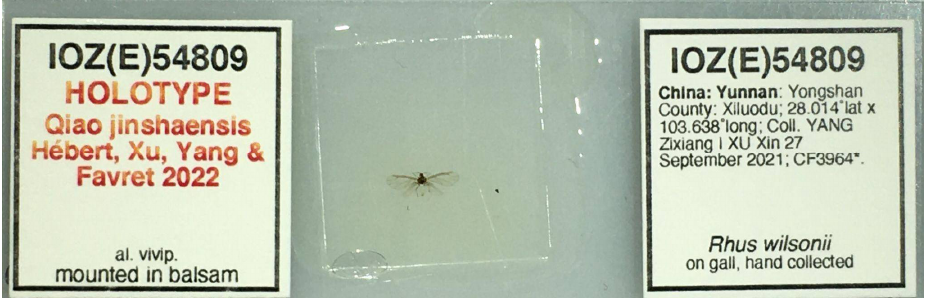
Figure 1. Holotype slide of Qiao jinshaensis sp. nov. (IOZ(E)54809).